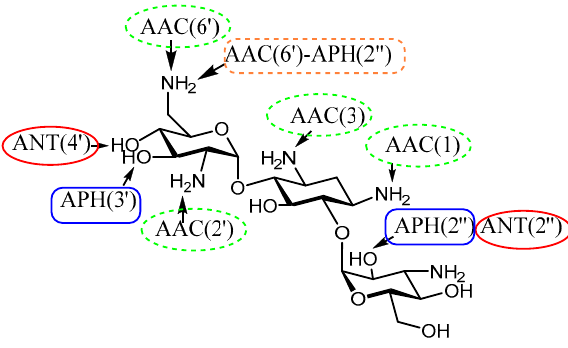
Figure 1. Susceptible positions in Kan B to AME modification.